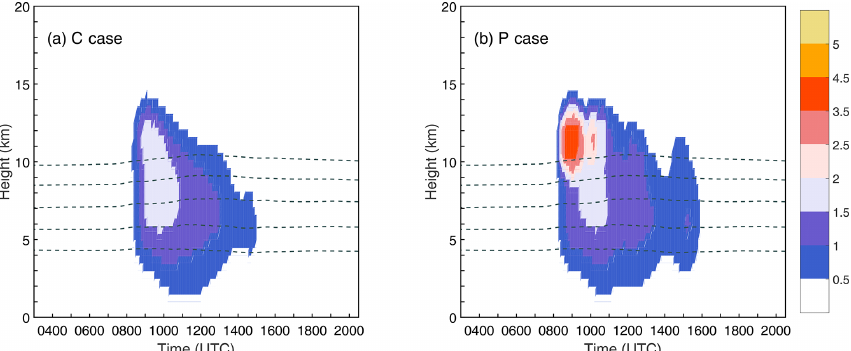
Figure 12. Temporal variation in the vertical profiles of peak latent heating (Kh − 1 , shaded) of (a) C case, and (b) P case. The 0, − 10, − 20, − 30 and − 40 ◦ C isotherms are shown by the dashed gray lines in (a) – (b) .